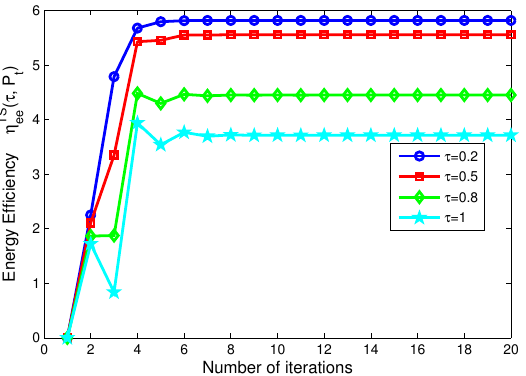
Figure 9. Energy efficiency versus number of iterations with different time switching slots for TS mode.